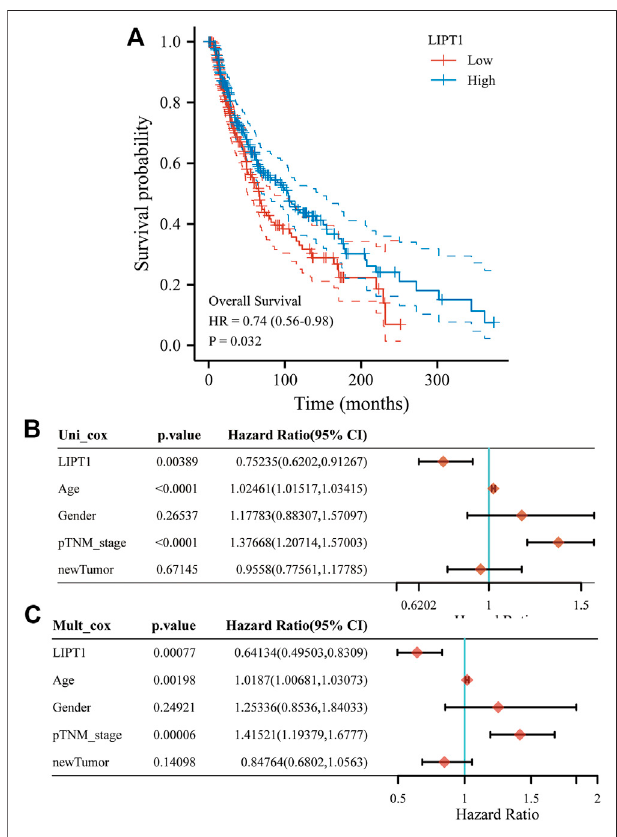
FIGURE 4 | Upregulated LIPT1 expression is connection with good outcomes of Skin Cutaneous Melanoma (SKCM). (A) The Kaplan – Meier analysis of SKCM patients with high and low LIPT1 expression level in the TCGA cohort. (B,C) Univariate (B) and multivariate Cox analysis of expression of LIPT1 and other factors in SKCM